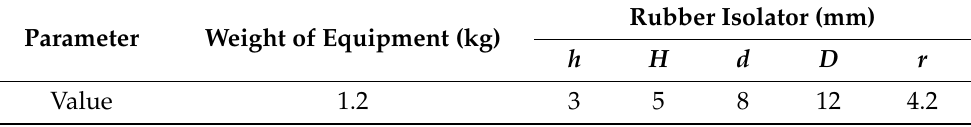
Table 1. Parameters of the isolation system.